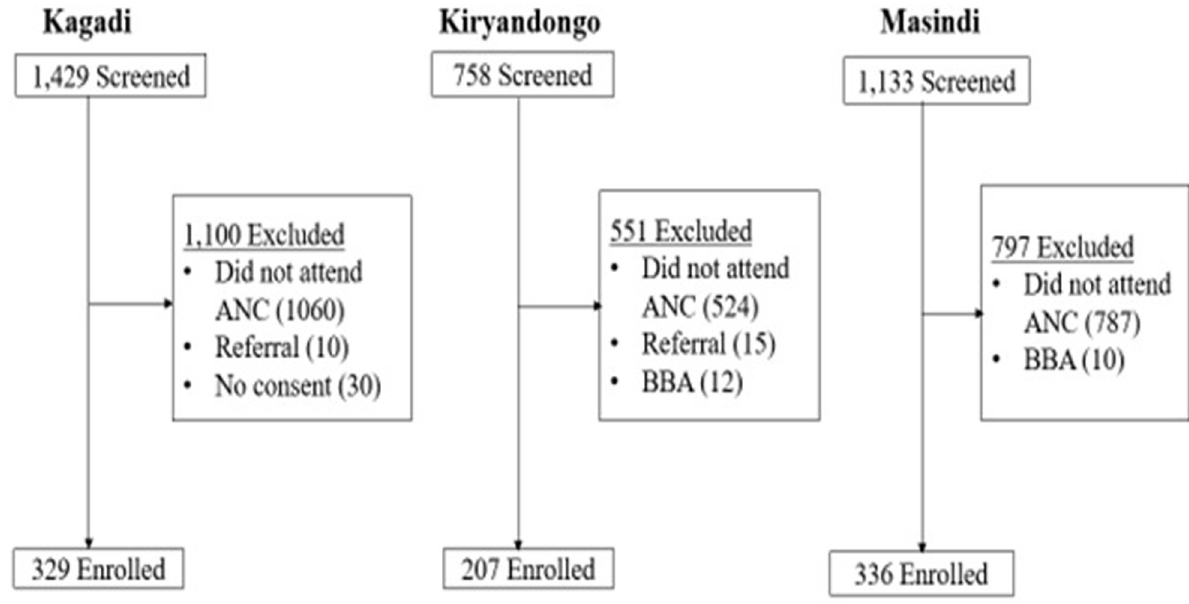
Fig 1. Flowchart. ANC = antenatal care; BBA = birth before arrival.